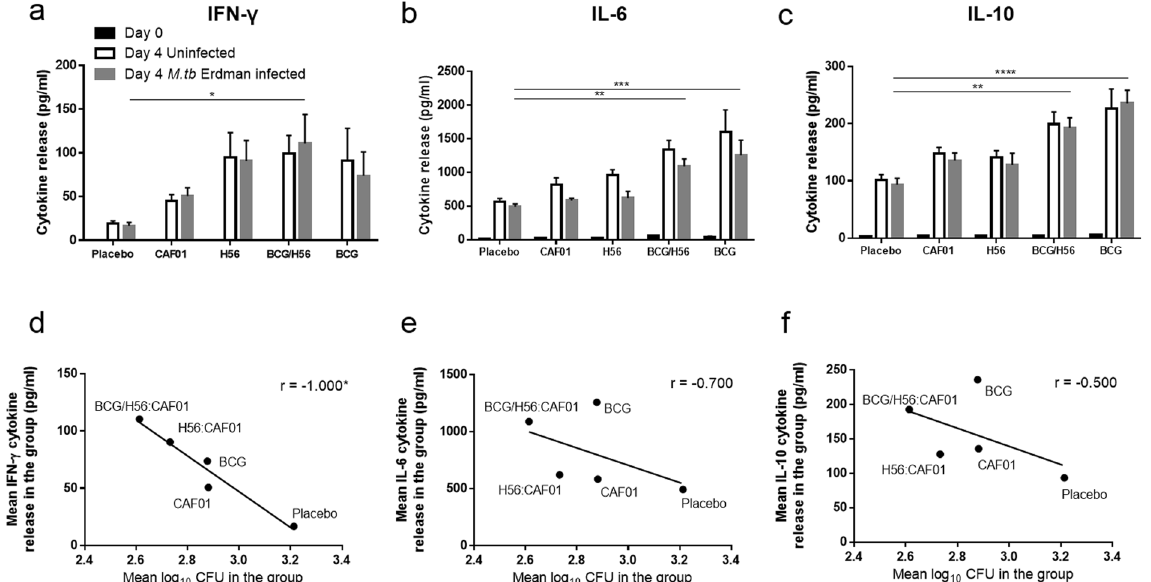
Figure 8. Cytokine release associated with vaccination but not infection. Groups of mice were immunised three times s.c. with 2-week intervals with H56 in CAF01, H56:CAF01 SBS with BCG or given placebo (Tris buffer) or CAF01 as controls. At the same time, as the first vaccination, a group of mice received a single dose BCG. Splenocytes were isolated one week after the last immunisation and used in the MGIA. Culture supernatants were analysed for the released cytokines IFN- γ ( a ), IL-6 ( b ) and IL-10 ( c ). Black bars indicate the levels of cytokines released from splenocytes before in vitro culture, while grey bars represent the levels of cytokines measured in the MGIA cultures after four days infection and white bars represent cytokines measured in cultures without infection. Bars represent mean + SEM of eight mice (CAF01 n = 10). For the groups of mice where growth inhibition and MSD data was available (n = 5), scatter plots of mean log 10 CFU values versus mean levels of IFN- γ ( d ), IL-6 ( e ) and IL-10 ( f ) measured in the same MGIA samples were drawn. One-way ANOVA with Dunnett’s multiple comparisons test was used to compare cytokine levels between vaccinated and placebo control groups ( a–c ). * p < 0.05; ** p < 0.01; *** p < 0.001; **** p < 0.0001. ( d–f ) Spearman’s rank * p <